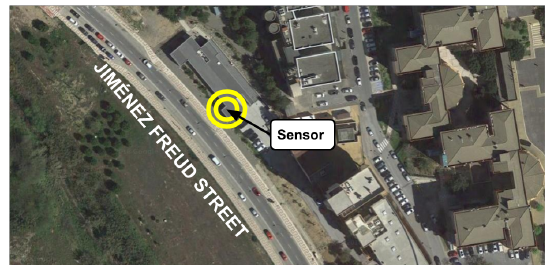
Figure 6. Location of the sensor (two circles) that captured the data used in this study.